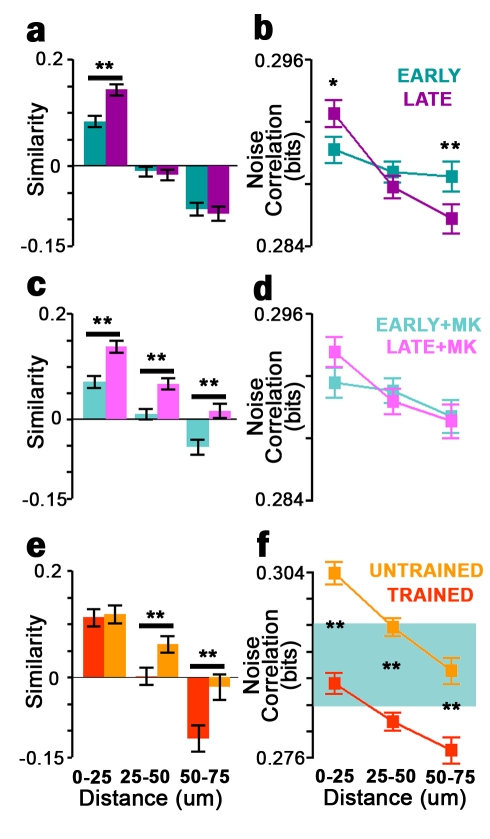
Training strengthens clustering of receptive fields and network correlations.(a–d) Tuning curve similarity (a,c) and mean noise correlation (b,d) of neuron pairs binned by spatial distance, during early (teal) and late (purple) epochs, in control (a,b) and MK801-treated (c,d) tadpoles. (e,f) Tuning curve similarity (e) and noise correlations (f) in tadpoles trained with four stimuli (0°–135°), binned by distance, in response to trained (orange) and untrained (yellow) stimuli. (f) Shaded area highlights the range of plots in (b,d). Noise correlations to untrained stimuli were significantly lower than in naive control animals (p<10−5, two-way ANOVA) and those to trained stimuli were significantly higher than in naive controls (p<10−5, two-way ANOVA). Error bars denote SEM. Control, n = 7 tadpoles (277 neurons), MK801, n = 7 tadpoles (255 neurons) (e,f) n = 3 tadpoles (152 neurons). *p<0.05; **p<0.01.